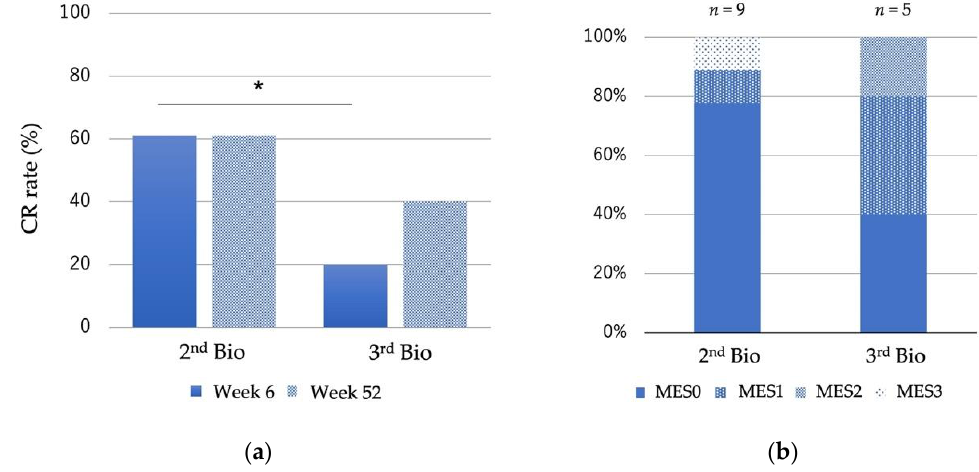
Figure 4. Clinical and endoscopic outcomes of patients treated with Vedolizumab as second bio and third bio. ( a ) Clinical remission rate at week 6 and week 52 (second bio n = 18, third bio n = 10). Treatment efficacy was assessed using the Lichtiger clinical activity index. ( b ) Endoscopic evaluation at week 52. Endoscopic severity was assessed using the Mayo endoscopic score. Differences between groups were analyzed using the Mann–Whitney’s U test. * p <